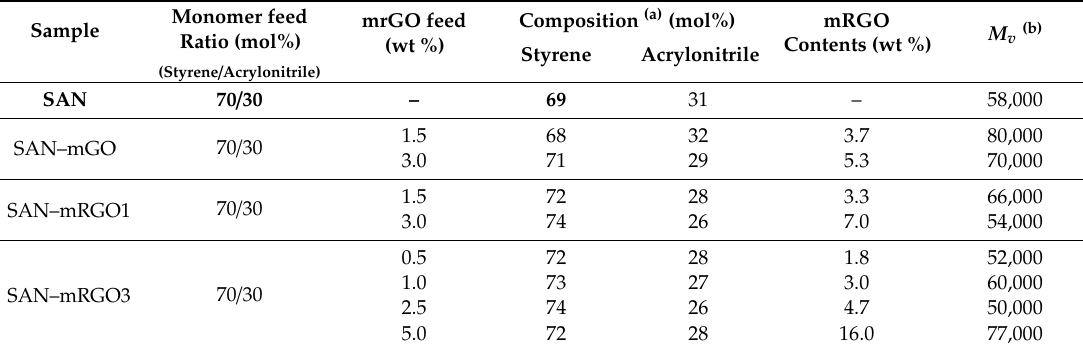
Table 1. Results of the in situ copolymerization of styrene and